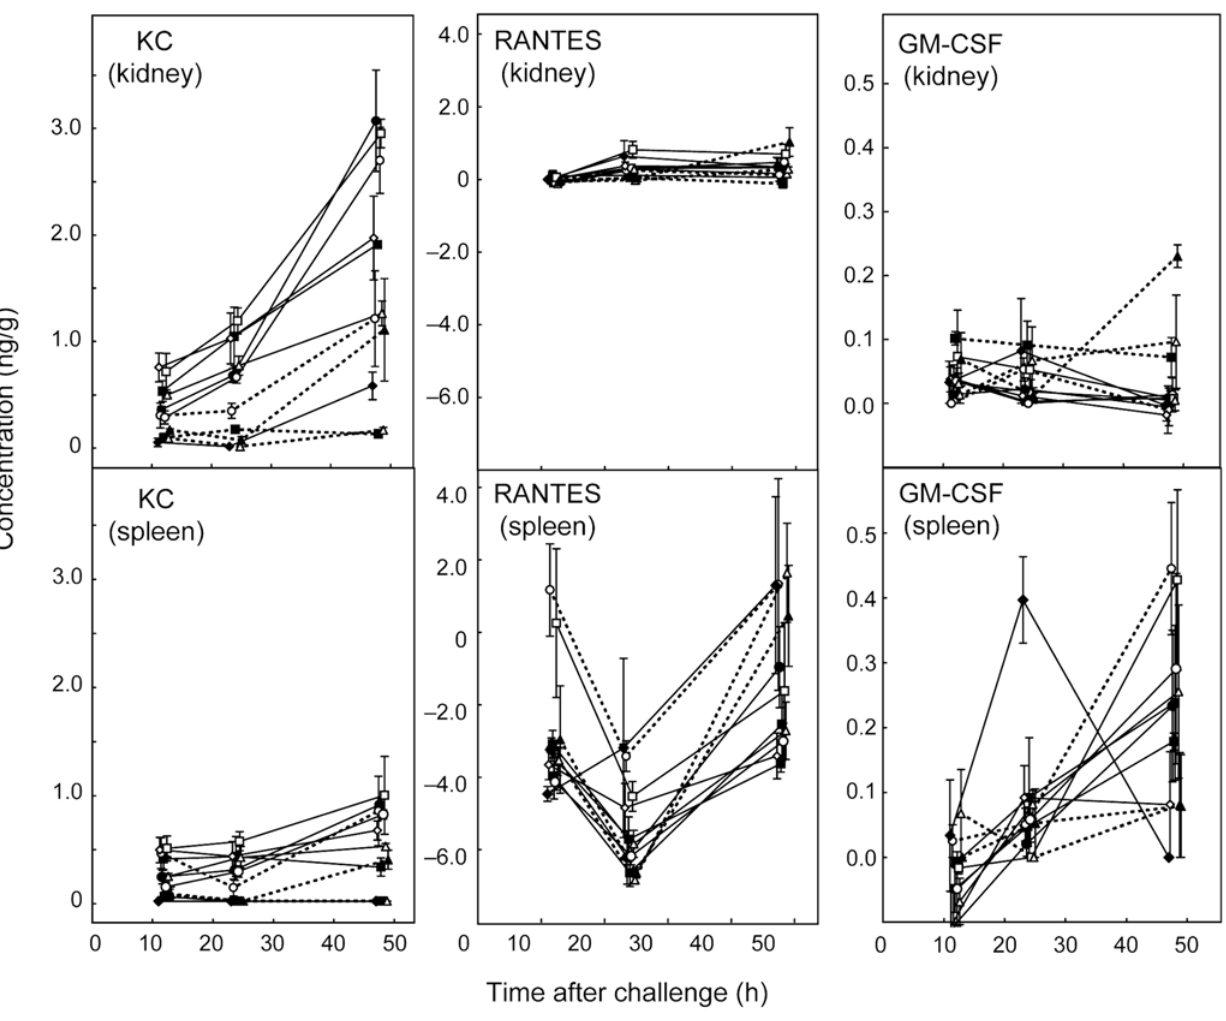
Figure 5. Time course of concentrations (ng/g) of KC, RANTES and GM-CSF in kidney and spleen samples from mice infected with 11 different C.albicans strains. Details as in Fig. 4.